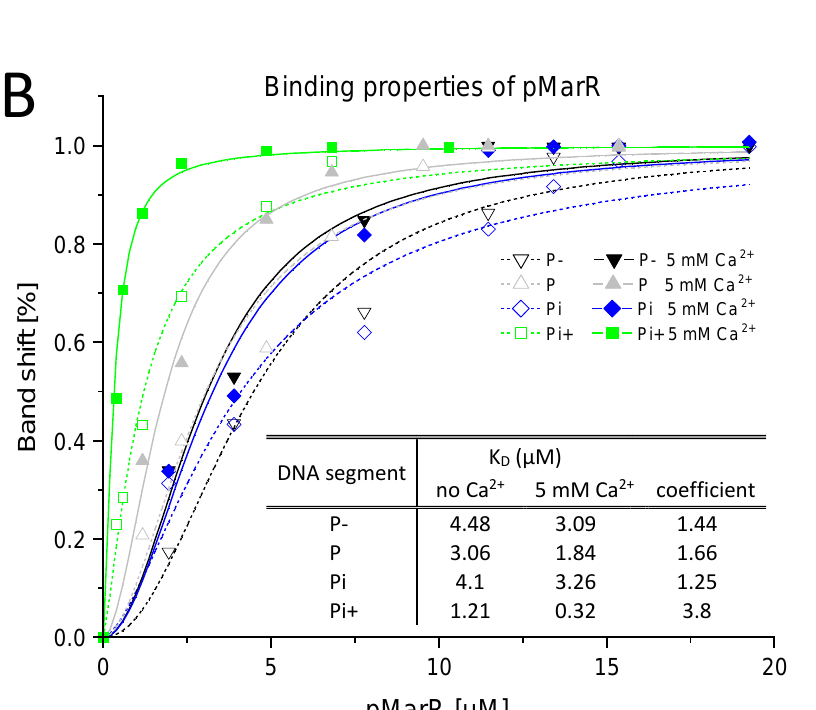
bound DNA. ( B ) Binding curves of quantified EMSAs of pMarR protein assaying P − , P, Pi, and Pi+ DNA segments in the absence or presence of Ca 2+ (Figure S6). Hyperbolic regression lines were generated by fitting with the Hill equation. The inserted table lists K D values calculated based on binding curves. The coefficient represents the factor by which the addition of Ca 2+ increased the binding